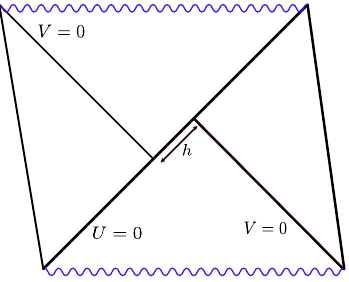
Fig. 20 Penrose diagram of the AdS 3 black hole geometry perturbed by a shock